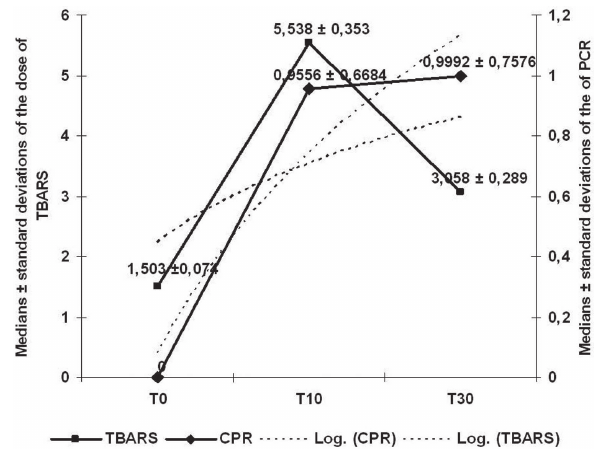
Fig 2. Simultaneous demonstration of the means and standard deviations of the concentrations of TBARS and CRP at T and T 30